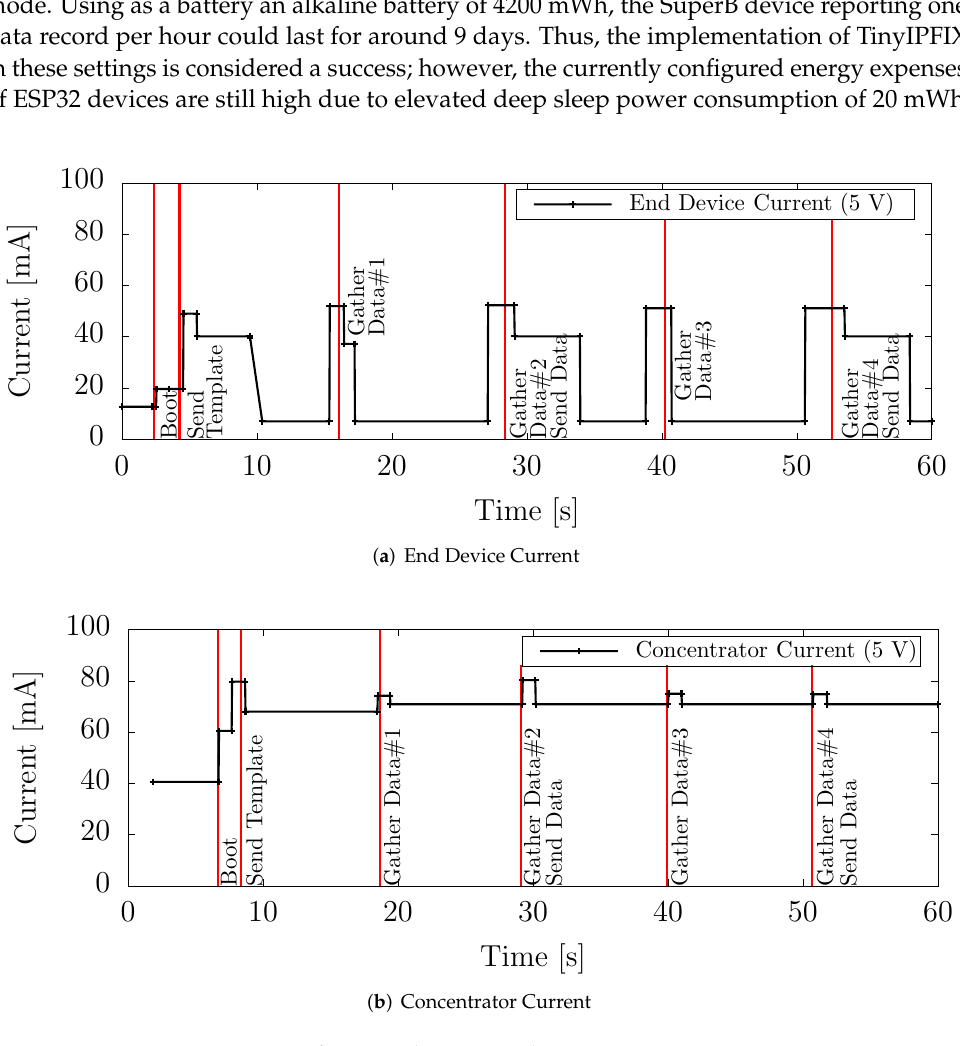
Figure 7. Current Measurements for an End Device and a